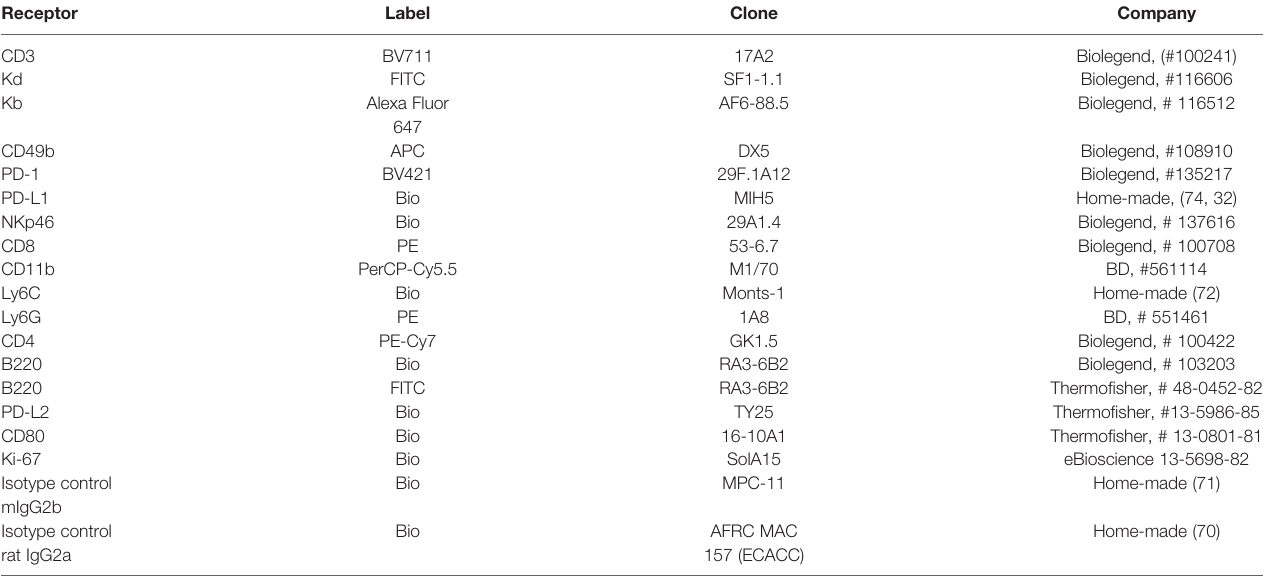
TABLE 1 | List of antibodies describing the speci fi city, labeling, clone name and the provider. Receptor